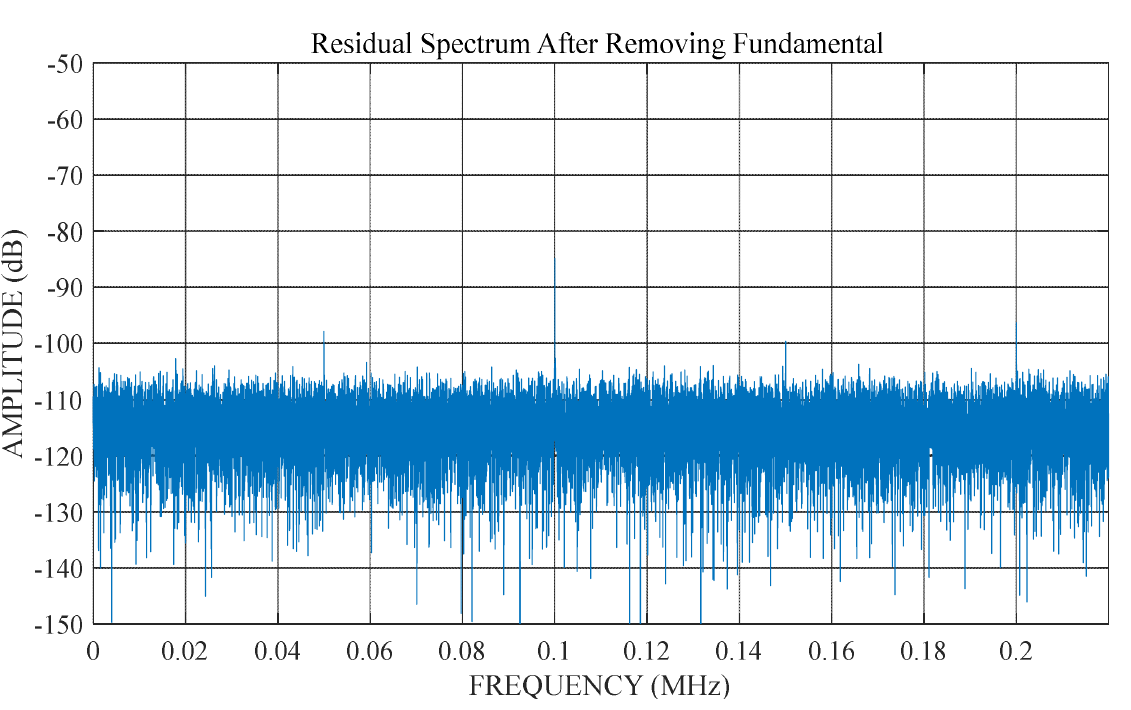
Figure 2. Spectral leakage in the DFT of the data for non-coherent sampling.